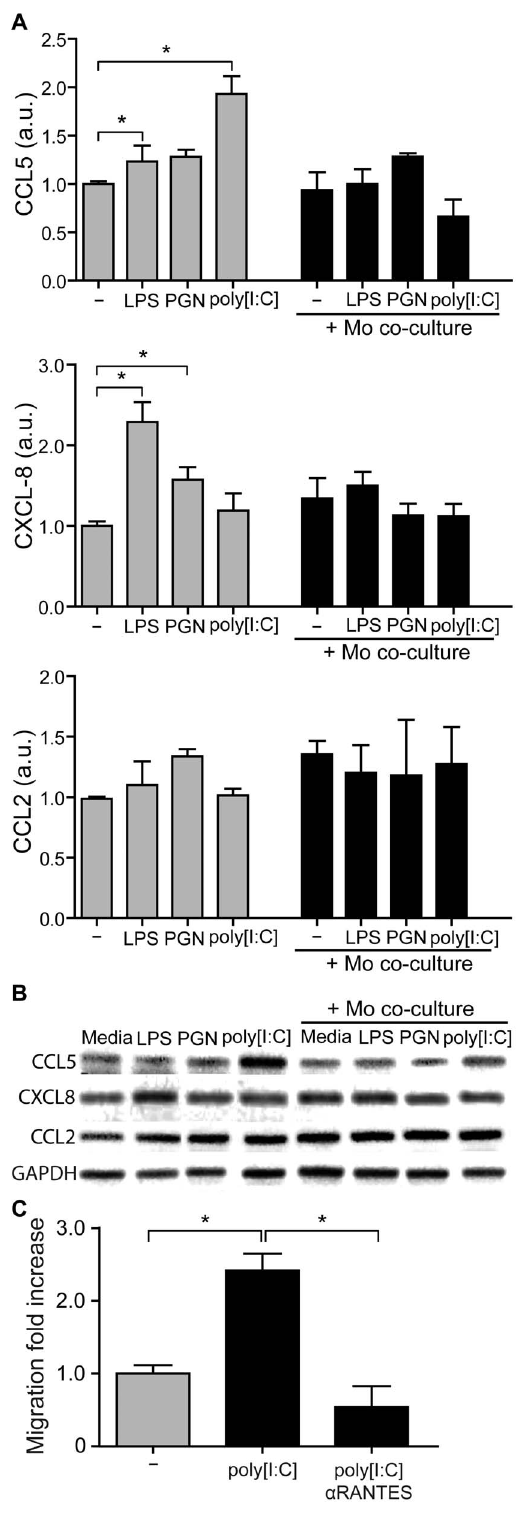
Figure 5. Trophoblast cells selectively reduce chemokine production after the interaction with maternal monocytes in the presence of PAMPs stimuli. Swan-71 cell line was cultured with LPS (10 m g/ml), PGN (10 m g/ml), or poly [I:C] (10 m g/ml) in a polystyrene plate in the absence or presence of 0.4 um pore-insert with CD14 + cells. After 24 hours, Swan-71 cells were recovered from the lower compartments and the expression of CCL5, CXCL8 and CCL2 ( A )